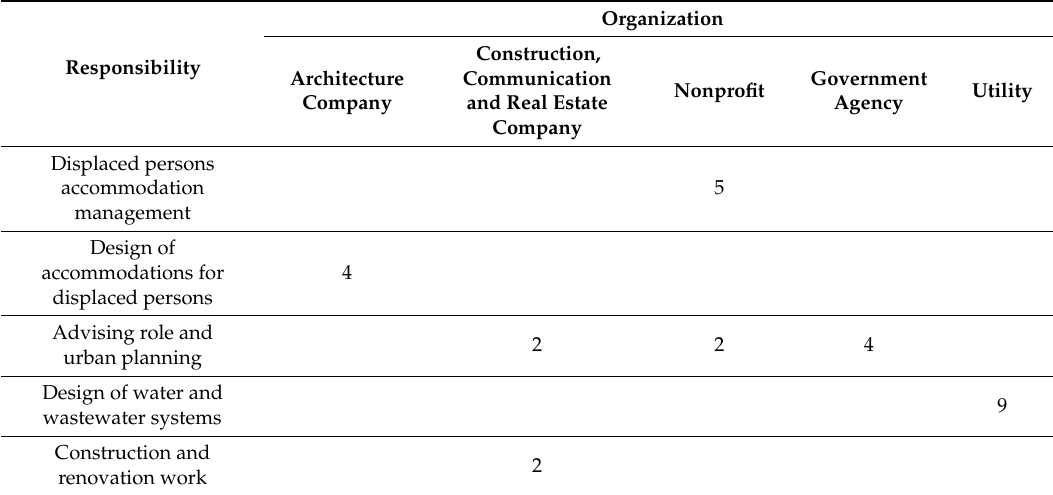
Table 2. Interviewee